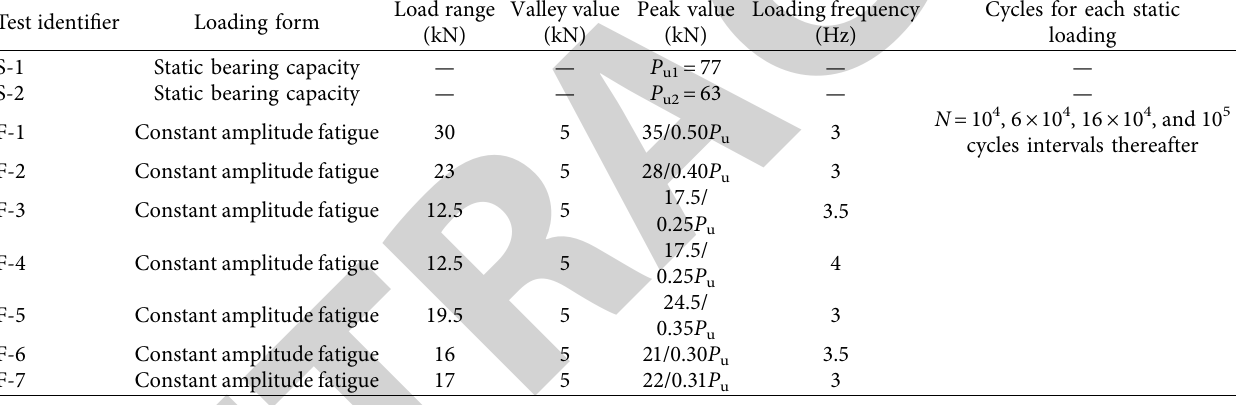
Table 2: Loading parameters of the test.